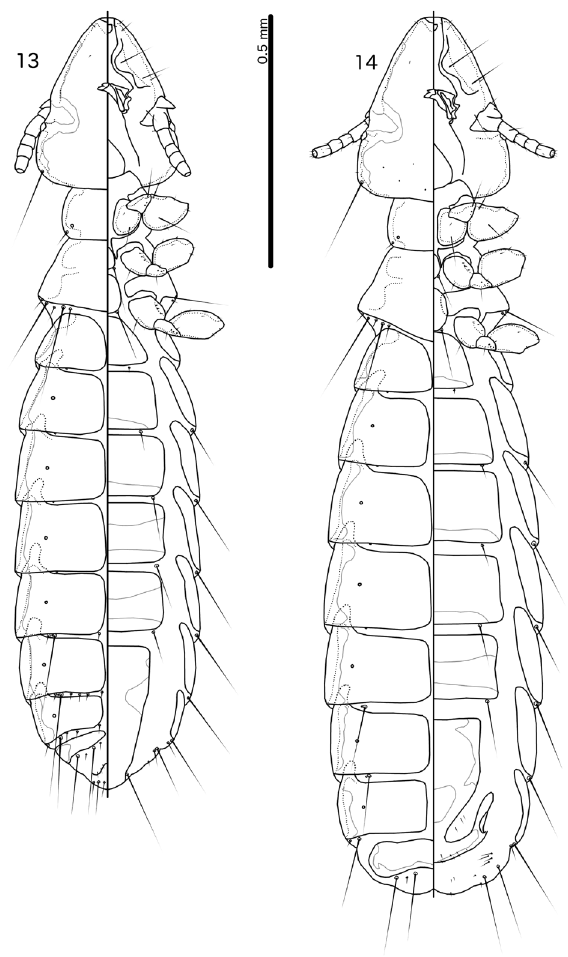
Description. Both sexes. Head flat dome-shaped (Fig. 15), lateral margins of preantennal area slightly convex, frons broadly concave. Marginal carina nar- row, deeply displaced and widened at osculum, median margin undulating. Ventral anterior plate small, shield- shaped. Head chaetotaxy and pigmentation patterns as in Figure 15; head sensilla and pts not visible in examined specimens. Preantennal nodi not bulging. Preocular nodi much larger than postocular nodi. Marginal temporal ca- rina moderate in width, with undulating median margin. Gular plate lanceolate, slender. Thoracic and abdominal segments and pigmentation patterns as in Figures 13, 14. Male. Thoracic and abdominal chaetotaxy as in Fig- ure 13. Basal apodeme with deeply concave lateral mar- gins (Fig. 16). Proximal mesosome roughly quadratic, with rounded corners, small (Fig. 17). Mesosomal lobes wide, highly convergent distally; rugose area limited to distal margin. Gonopore wider than long. Penile arms not reaching distal margin of mesosome. Parameres slender (Fig. 18), distal part elongated; pst1– 2 not visi-